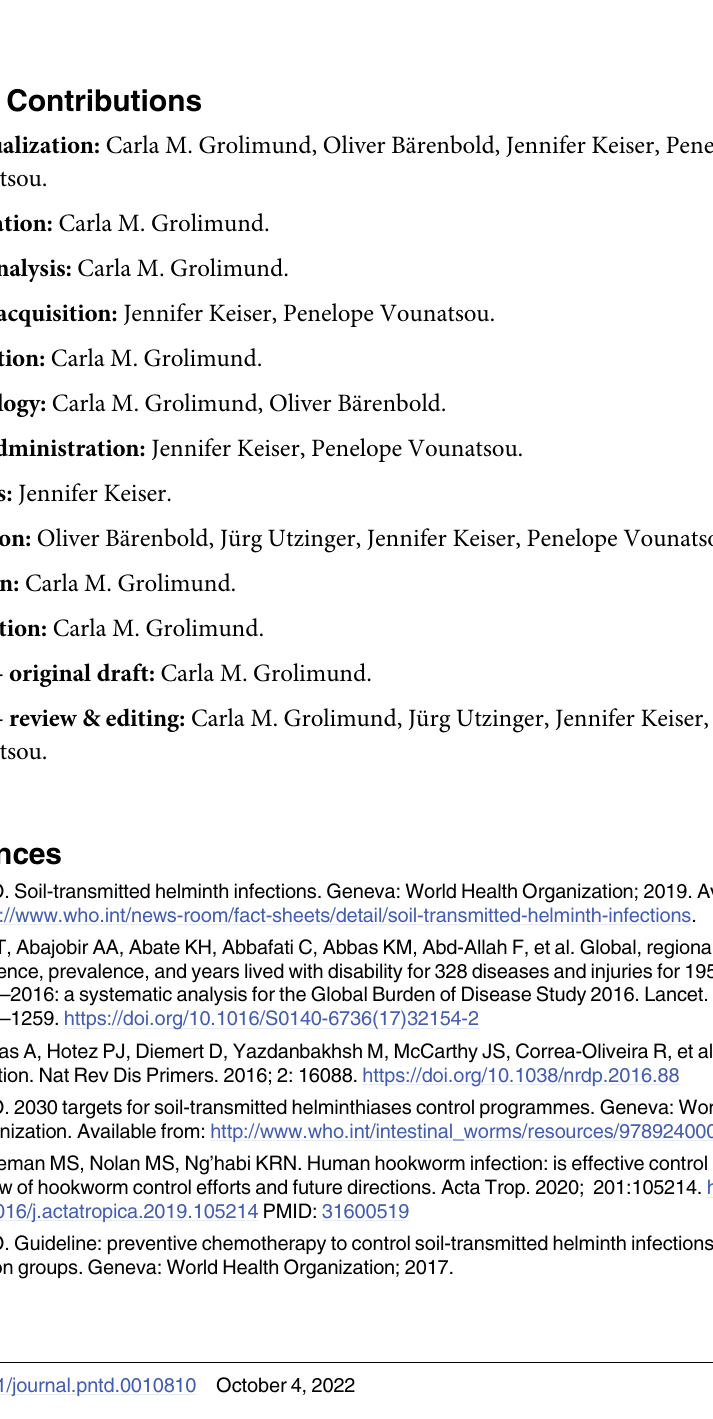
S1 Fig. The plot shows the estimated mean and 95% Bayesian credible interval for the mean egg intensity at baseline and follow-up for the different treatment arms for hook- worm. The black dots show the data. (TIFF) S2 Fig. Sensitivity of the Kato-Katz technique for hookworm for one, two, and three sam- ples. The lines show the mean sensitivity and the shaded areas indicate the 95% BCI. (TIFF) S1 STARD